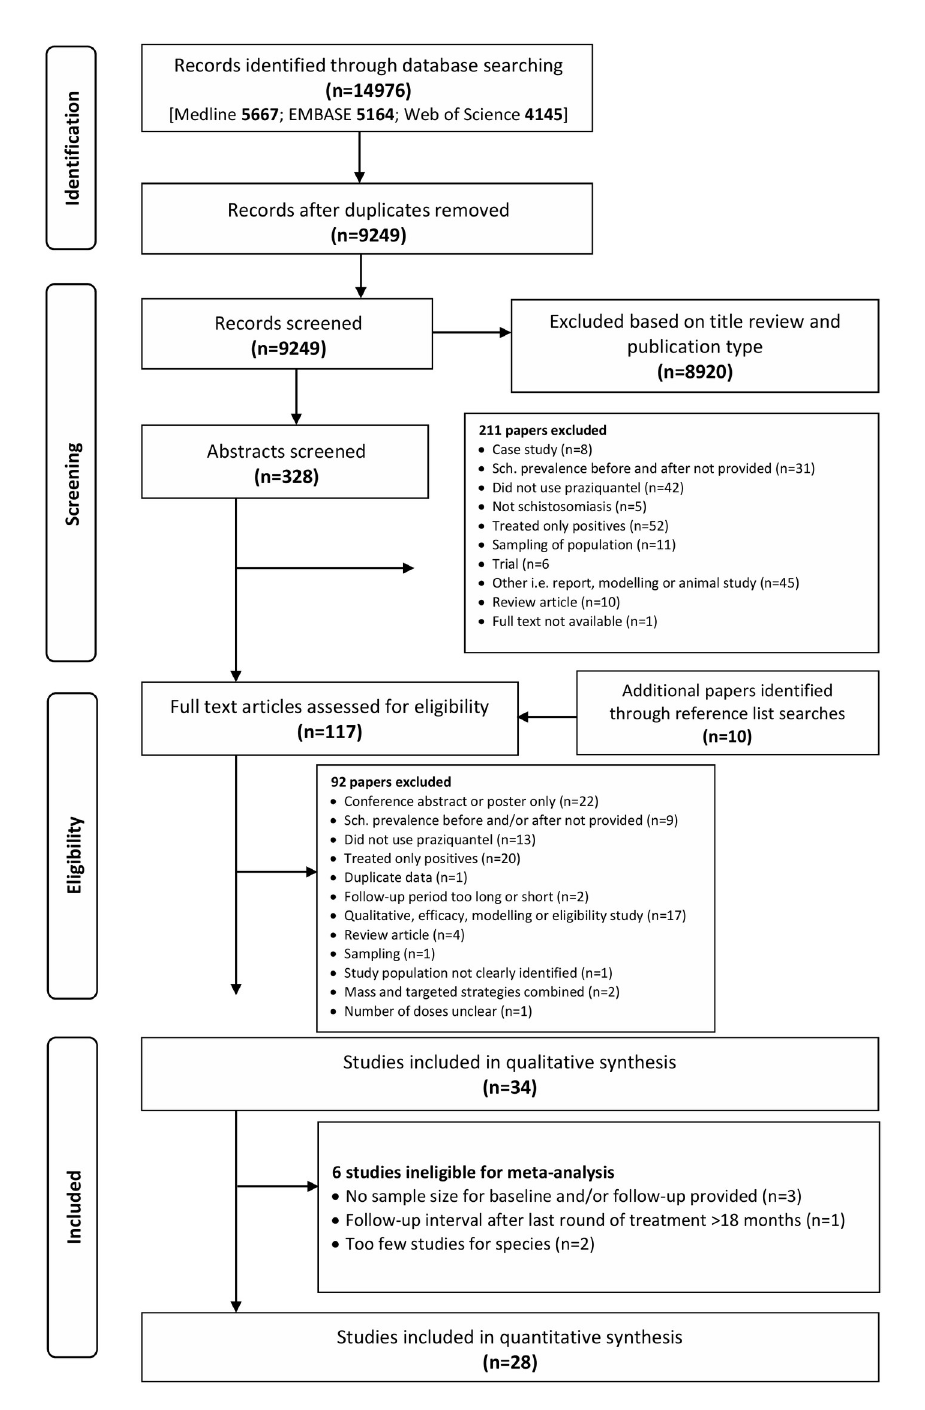
Fig 1. Process of selection of studies for inclusion in this